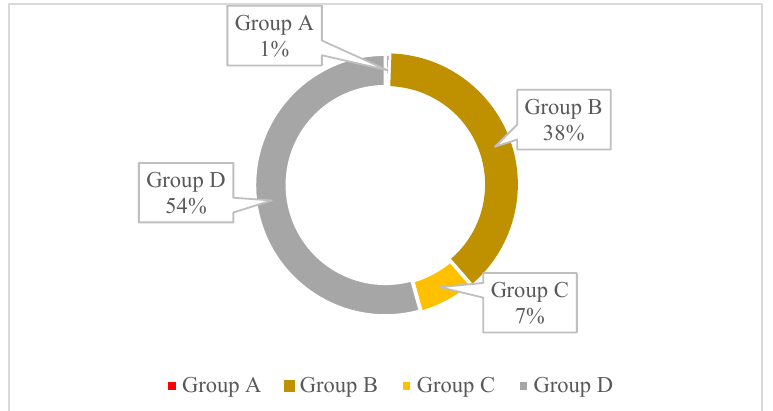
Figure 4. Percentage of resistance in each of the four antibiotic categories according to Emma’s categorisation, in the total of 1335 isolates. The classification comprises four categories: category A—”Avoid”, B—”Restrict”, C—“Caution”, and D—“Prudence”.